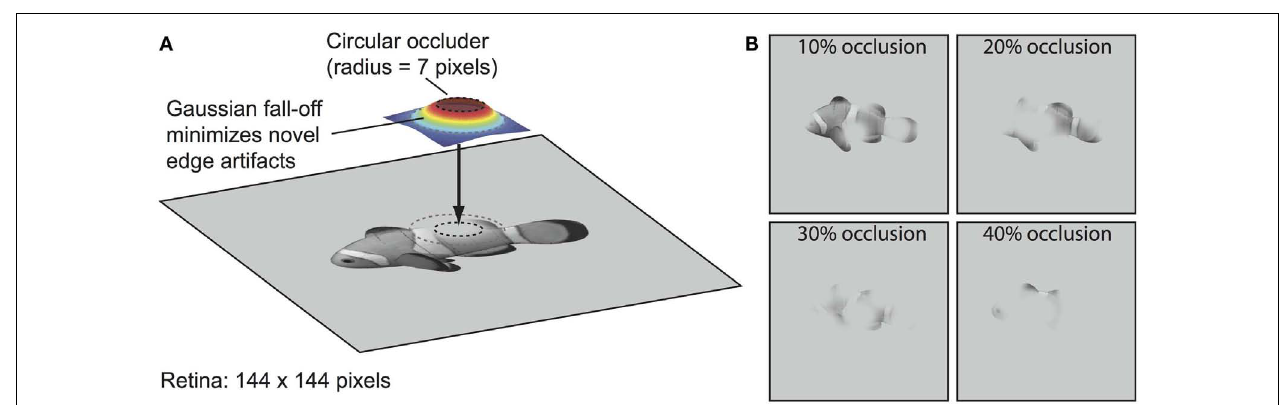
background gray level such that image regions that fell within the circle region at the top of the filter were completely occluded with the background gray level. (B) Examples of different occlusion levels. Percent occlusion parameterized an equation that specified the number of times to apply the filter (see Methods). Additional occlusion examples are shown in